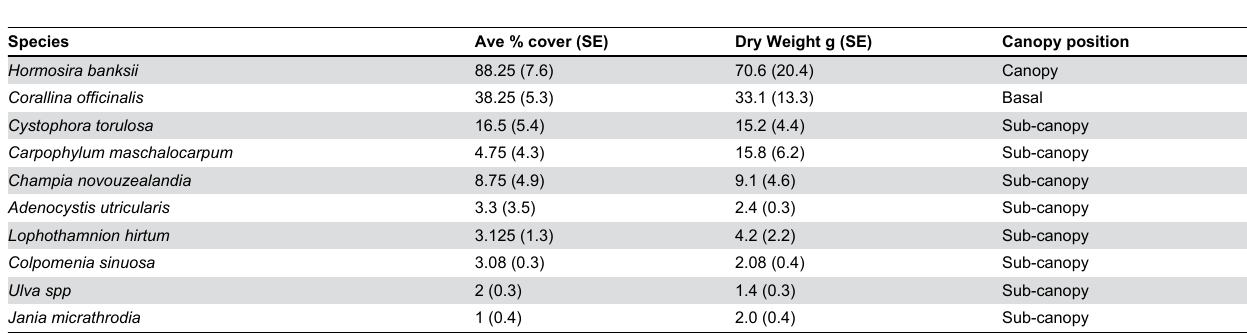
Table 2. Average percent cover, average dry weight (±SE) and the canopy position of macroalgal species found in the assemblages used for laboratory